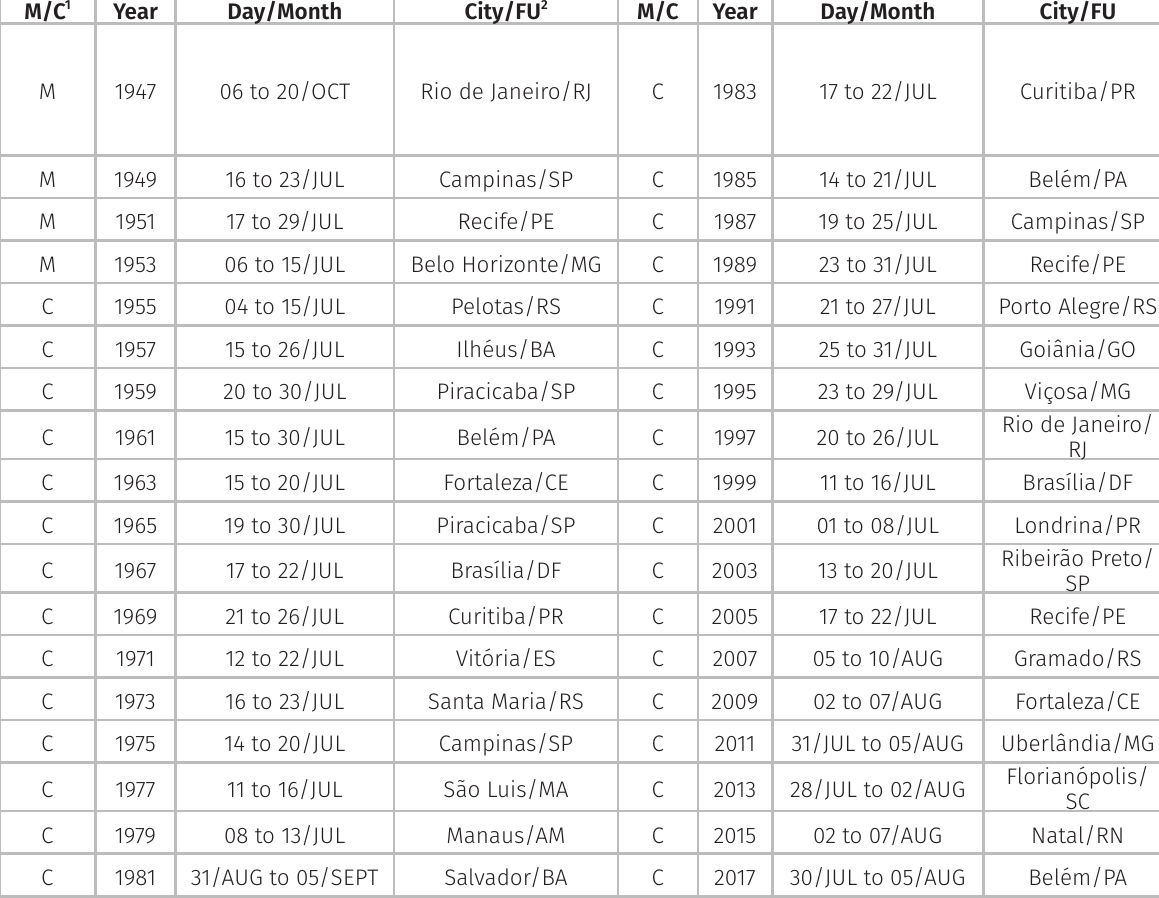
Table I. General information regarding the Brazilian Congress of Soil